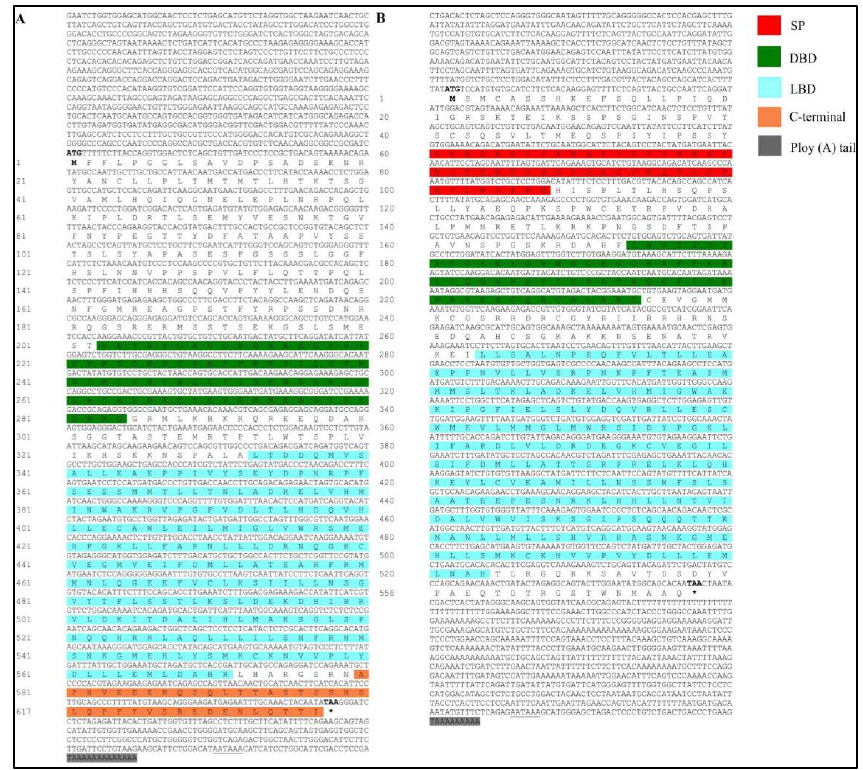
Figure 1. The cDNA sequence and amino acid of ERs of P. sinensis . The start codon and end codon are in bold black, * denotes the termination codon, and the underline denotes the 3 ’ untranslated region with the tailing signal AATAAA. SP: signal peptide. DBD: DNA-binding domain. LBD: ligand-binding domain. ( A ) The cDNA sequence and amino acid of ERα . ( B ) The cDNA sequence and amino acid of ERβ .